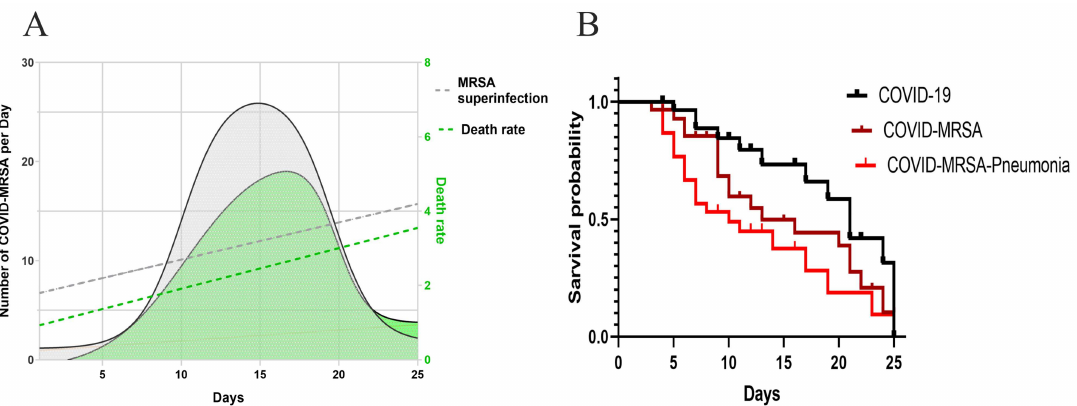
Figure 2. ( A ) The data of COVID-MRSA superinfection and death rate revealed that the MRSA super- infection was evident after 12 days, while the mortality rate increased after 10 days of hospitalization. The Wilcoxon and Spearman correlation analyses showed a significant association between continuous variable and hospitalization days (r = 0.94; p < 0.001). ( B ) The black curve indicates COVID-19 infection; the orange curve displays COVID-MRSA, and the red curve shows COVID-MRSA pneumonia. The survival comparison is shown among three states of COVID-19 that revealed those patients with COVID-MRSA pneumonia were subjected to a higher death rate ( p <